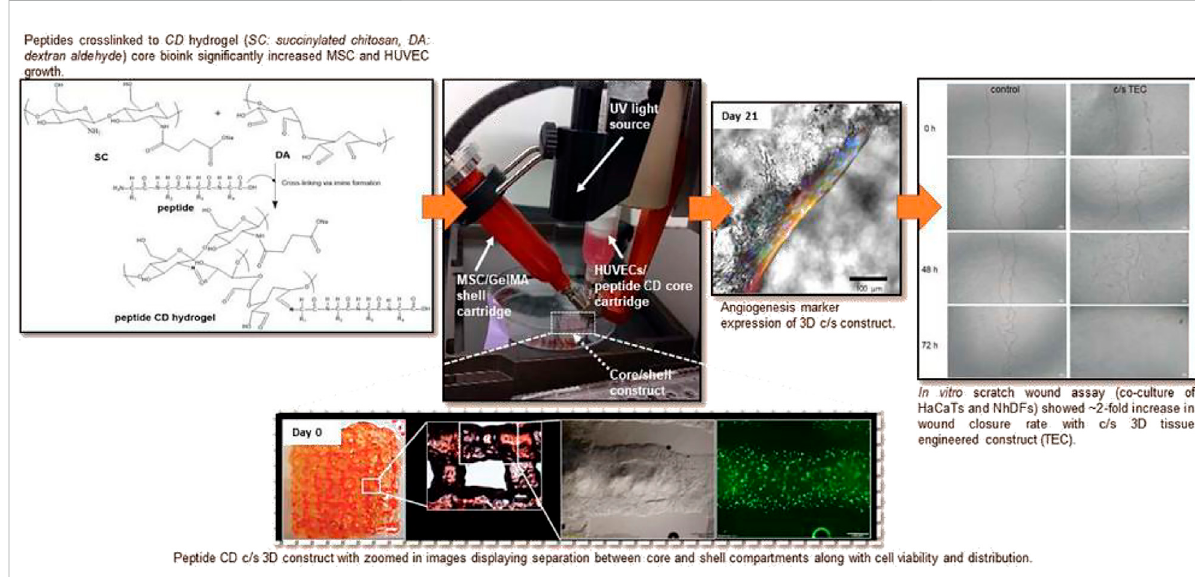
FIGURE 3 Peptide chitosan/dextran core/shell vascularized 3D constructs for wound healing. Reproduced with permission from ref (Yang et al.,